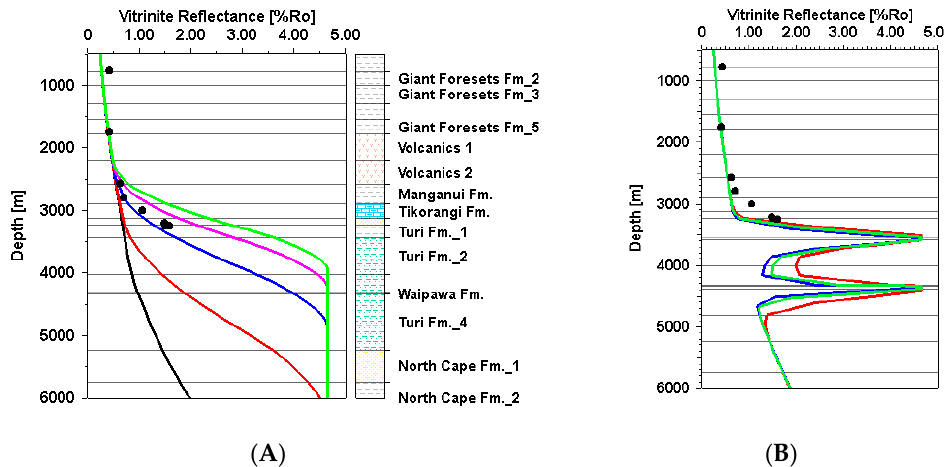
Figure 18. 1D models of Kora-1 well showing the sensitivity of the system to changes in ( A ) change of the basal heat flow during volcanic activity, and ( B ) sill intrusion thickness.